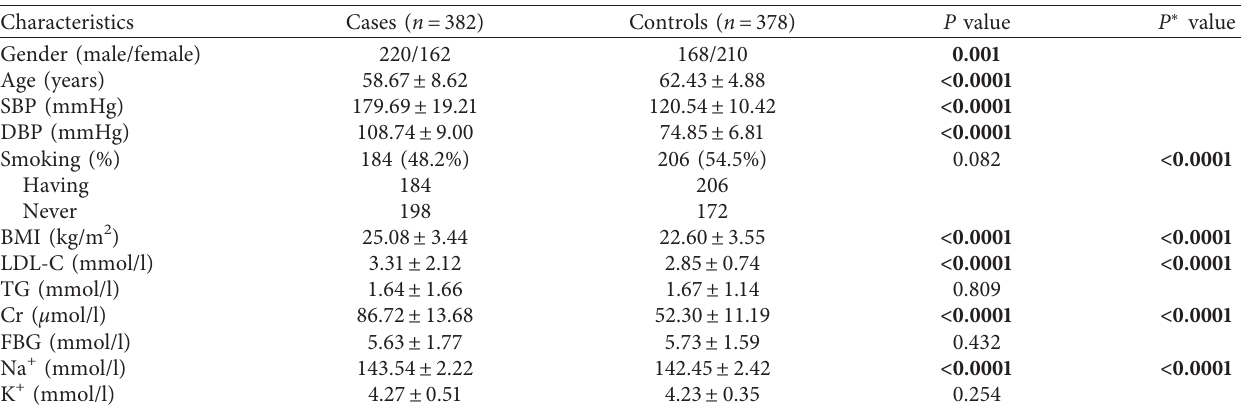
Table 2: General characteristics of all individuals.